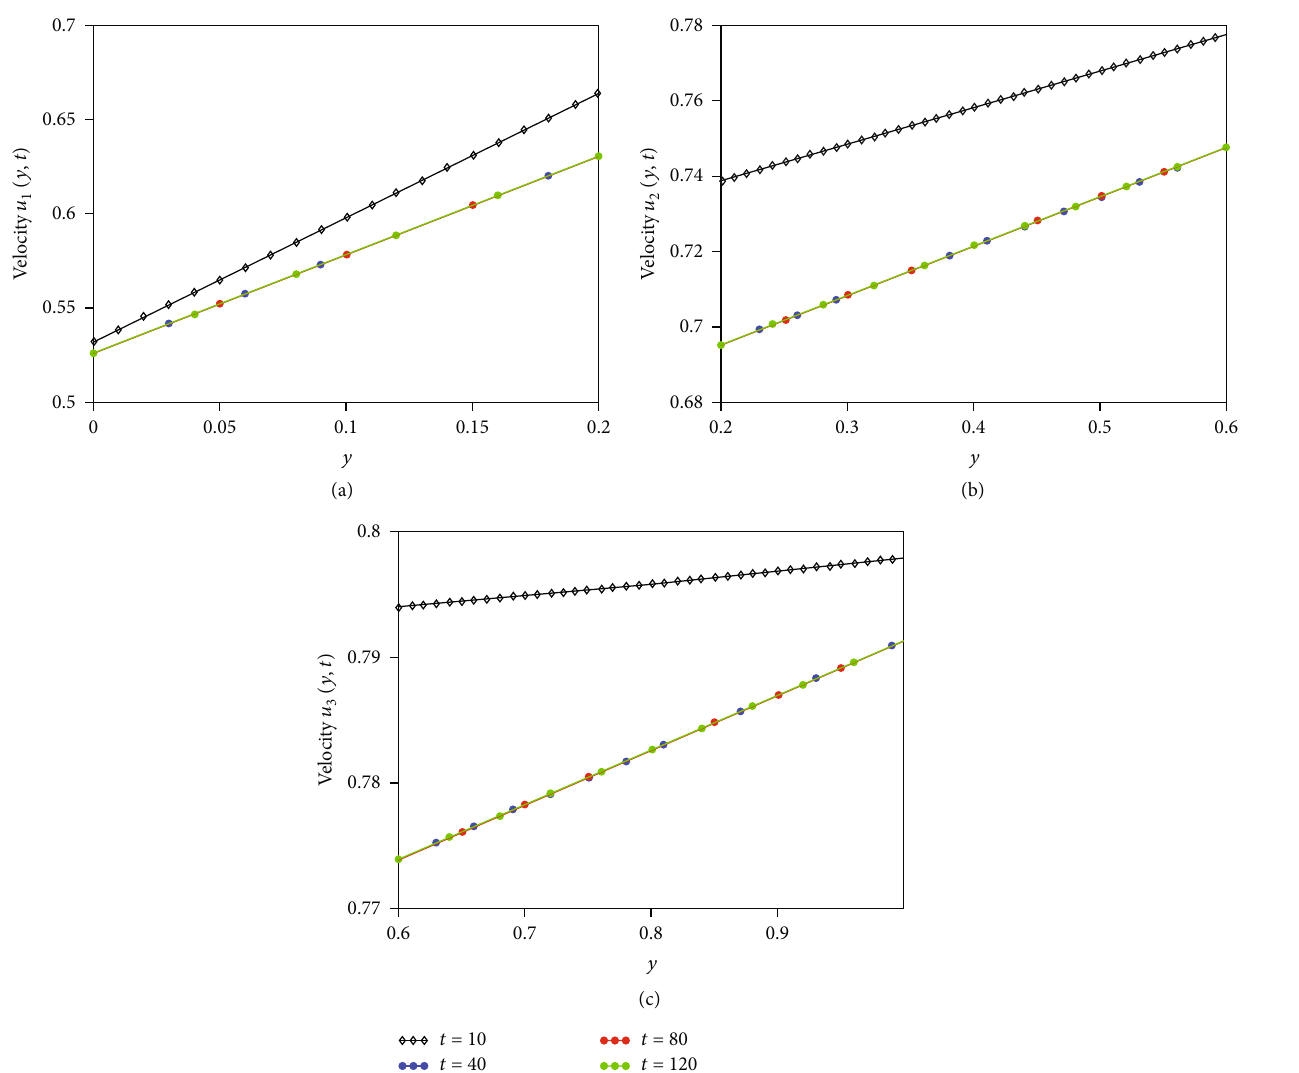
Figure 14: The pro fi les of velocity u = 1, a = 1 : 3, a a 1 2